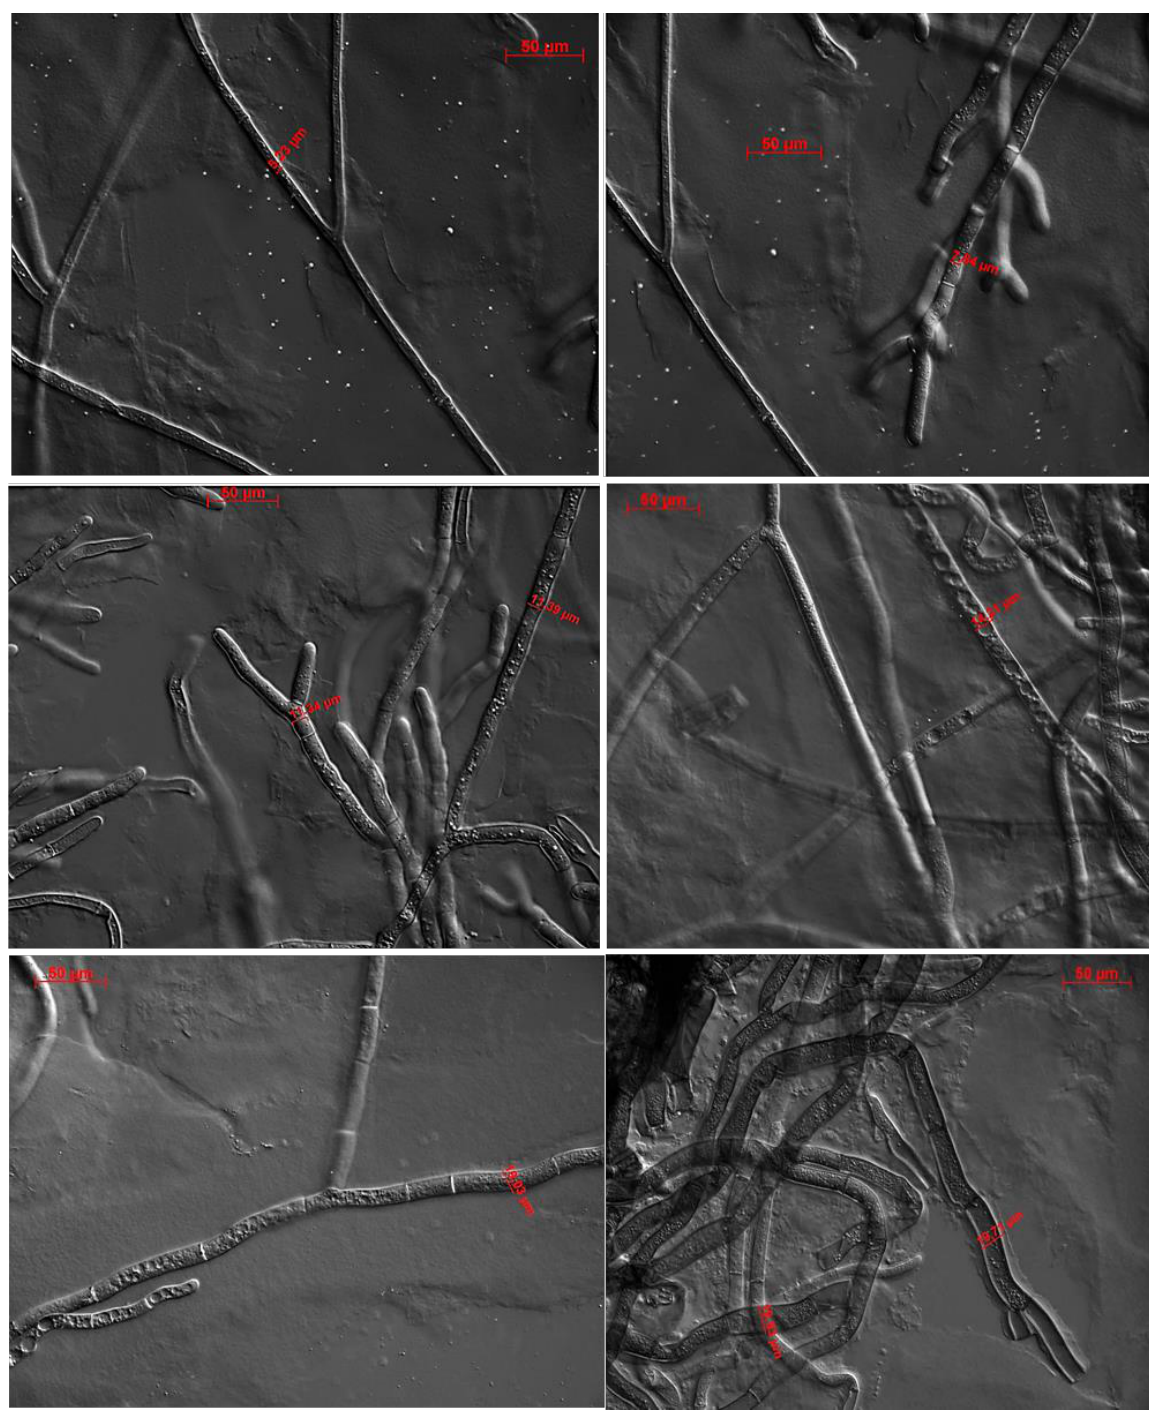
Figure 4. Morphological phenotypes of hyphae of the swnT transformants and WT S. leguminicola. Differential interference contrast (DIC) micrographs of S. leguminicola hyphae grown at 26 C for 72 h. WT hyphae (upper panel) showing hyphal width 5.23 μm to 7.84 μm. swnT transformed T10 (middle panel) hyphal width 11.34 μm to 14.21 μm and pSilent- swnT transformed T5 (lower panels) hyphal width 19.03 μm to 19.83 μm. Bar, 50 μm. 3.3. Comparison of Swainsonine and Slaframine Concentrations (Ratio) in Mycelia Versus the Agar Silencing swnT altered the ratio of the swainsonine and slaframine in the mycelia rel- ative to the agar. There was a statistically significant higher ratio of swainsonine and